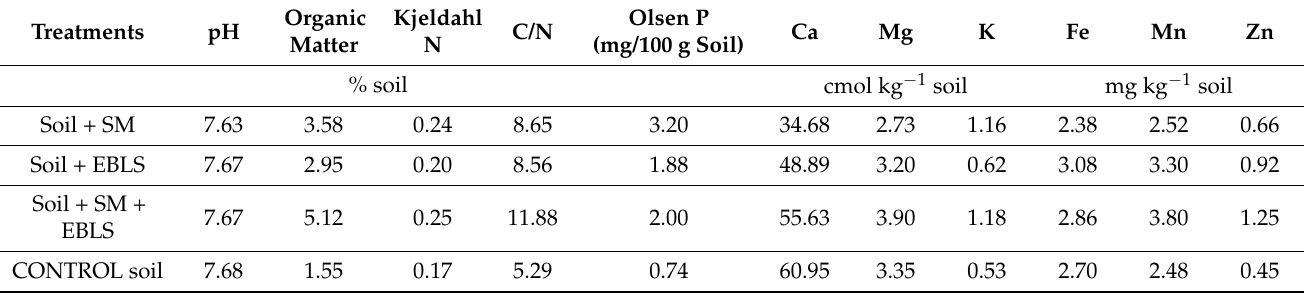
Table 2. Properties of the four soil mixtures (substrates) after the application of organic amendments (sheep manure, or SM, and litter from evergreen broadleaf species, or